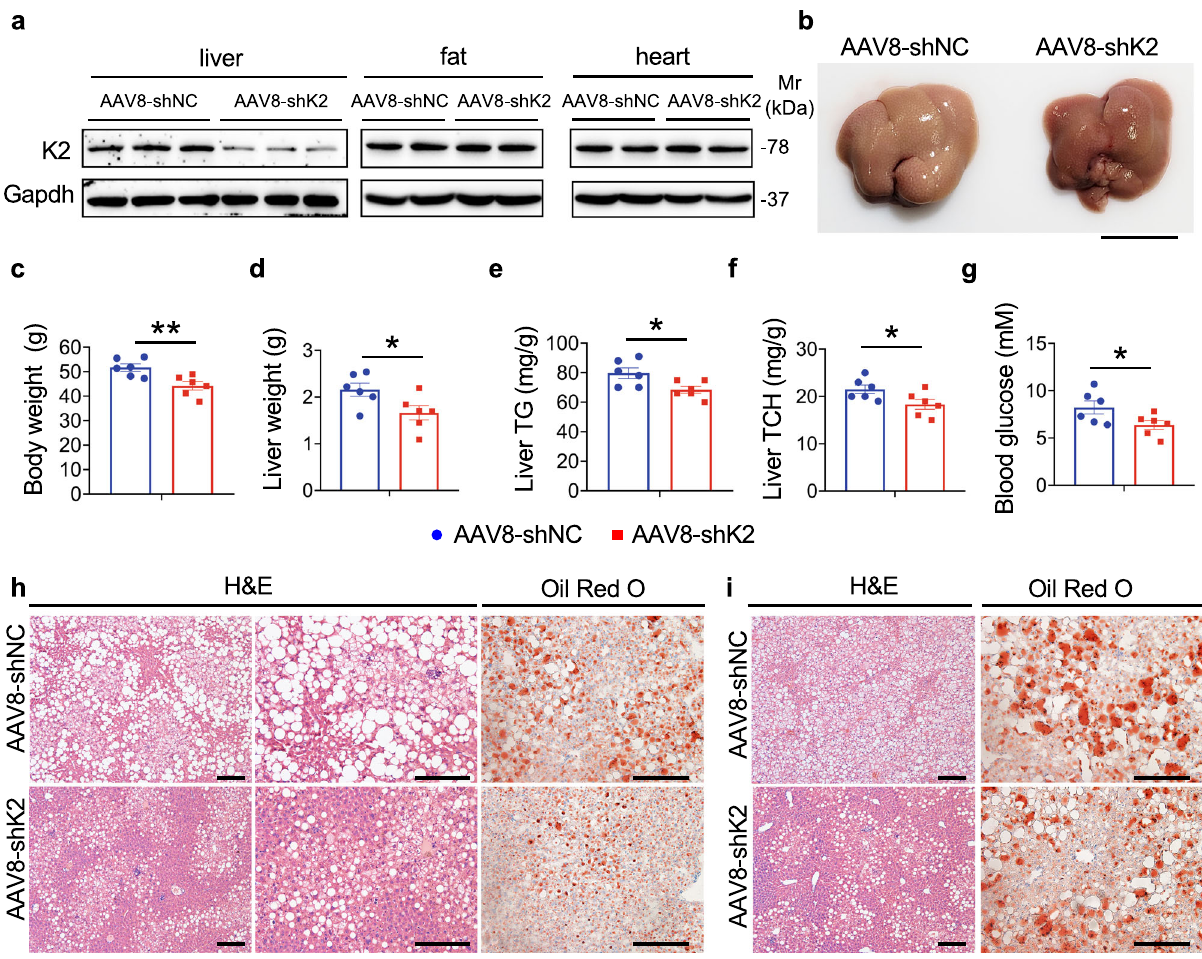
Fig. 8 Kindlin-2 knockdown attenuates hepatic steatosis in HFD and ob / ob mice. a Eight-week-old C57BL/6 male mice were fed with HFD for 8 weeks and then injected with AAV8 expressing Kindlin-2 shRNA (AAV8-shK2) or a negative control shRNA (AAV8-shNC) through the tail vein, followed by another 8 weeks of HFD feeding. Expression of Kindlin-2 in livers and other organs of mice of both groups was determined by western blotting. Protein extracts (20 μ g) were used for western blotting from fat, heart, and liver. b Gross liver appearance, c body weight, and d liver weight ( n = 6). Scale bar, 1 cm. e Liver TG (normalized to liver weight) ( n = 6). f Liver TCH (normalized to liver weight) ( n = 6). g Blood glucose level ( n = 6). h Representative images of H/E staining and Oil Red O staining of liver sections. i Images of H/E staining and Oil Red O staining of liver sections of ob / ob mice. Eight-week- old ob / ob male mice fed on NCD were injected with AAV8-shK2 or AAV8-GFP. Mice were fed on NCD for another 8 weeks before sacri fi ce. Scale bar: 100 μ m. c – g Data are presented as mean ± SEM. * P < 0.05, ** P < 0.01, determined by two-tailed Student ’ s t -test. h , i Data are representative of three biologically independent shRNA were transiently transfected with the FOXO1 expression plasmids. Twenty- cultured cells or tissue samples using Trizol (Takara), according to the manu- four hours after the transfection, the cells were incubated with 100 μ g/ml cyclohex- facturer ’ s instructions. RNA quality was assessed on a NanoDrop 2000 to obtain the 260/280 ratio. Samples with a ratio of 1.8 – 2.0 were processed for gene expression analysis. One microgram of mRNA was reverse-transcribed into com- plementary DNA by using the PrimeScript RT Reagent Kit with gDNA Eraser (Takara) according to the manufacturer ’ s protocol. SYBR Green (Takara) was applied to quantify PCR ampli fi cation. Expression levels were calculated using the Δ Ct-method. The primer pairs used in this study are described in Supplementary Table 2 and Supplementary Table 3. GTT and insulin tolerance test (ITT) . For GTT, after 16h fasting, mice were intraperitoneally injected with glucose with a dose of 2g/kg body weight. Glucose levels were measured in blood taken from the tail vein at the indicated times after glucose injection. For ITT, after fasting for 6h, HFD-fed mice were intraper- itoneally injected with 1 unit of insulin per kg body weight. Glucose levels were then measured in blood taken from the tail vein at the indicated times after insulin injection. Metabolic cages experiments . Metabolic cage experiments were performed at Quantitative real-time PCR analysis . qRT-PCR analyses were performed Brain Cognition and Brain Disease Institute, Shenzhen Institutes of Advanced Technology using CLAMS (Columbus Instruments). EE was calculated from VO 2 according to our previous protocol 44 . Brie fl y, total mRNA was isolated from